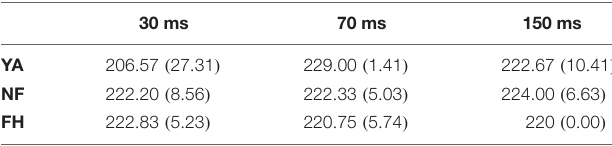
TABLE 2 | Average number of trials (SD) that survived preprocessing for subsequent time-frequency analysis for each group and illusory SOA